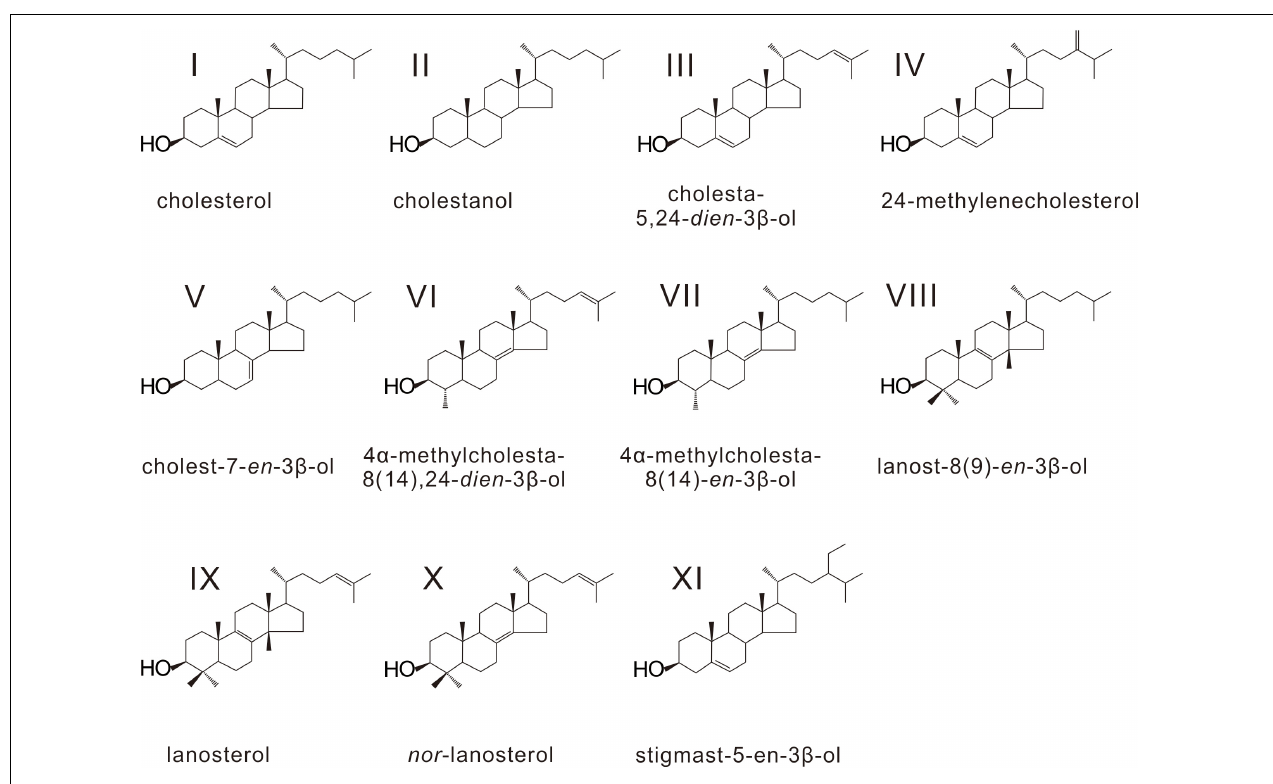
FIGURE 6 | Structures of sterols found in soft tissues of seep bivalves in the South China